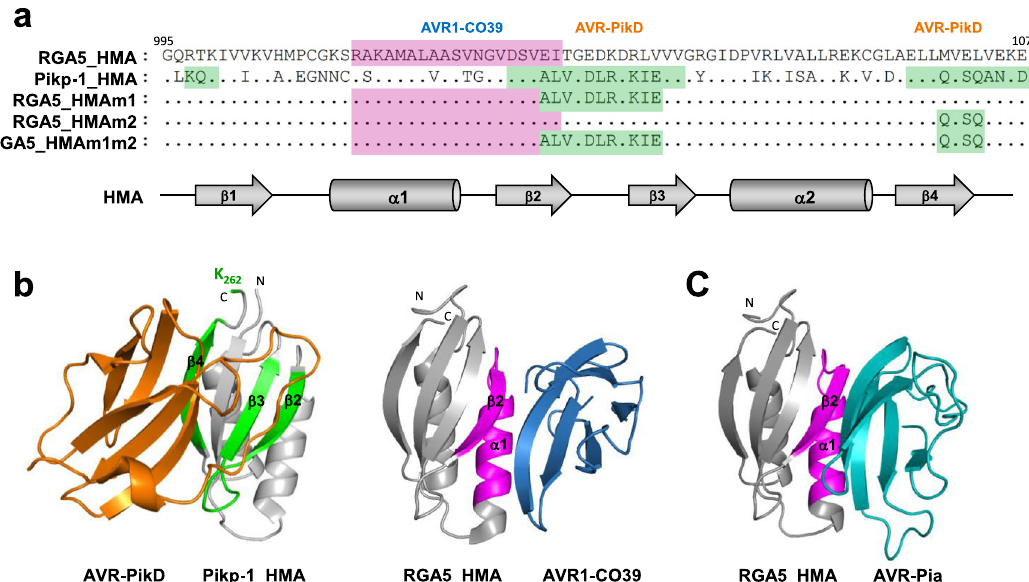
Fig. 1 Structure-guided engineering of the HMA domain of RGA5 to introduce the AVR-PikD binding surface. a Sequence alignment of the RGA5 and Pikp-1 HMA domains. The residues constituting the AVR1-CO39 and AVR-PikD binding interfaces are highlighted in pink and green, respectively. Residues in strands β 2/ β 3 and β 4 targeted respectively by the m1 and m2 mutations are highlighted in green in the different RGA5_HMA variants. Secondary structure elements of the HMA domain are shown below in gray. b Crystal structure of the AVR-PikD/Pikp-1_HMA (left) and AVR1-CO39/RGA5_HMA (right) complexes (PDB_6G10 and PDB_5ZNG, respectively). AVR-PikD (orange) binds the HMA domain of Pikp-1 through residues in β 2/ β 3, β 4, and K262 (green) and AVR1-CO39 (blue) interacts with the HMA domain of RGA5 through its α 1/ β 2 surface (pink). c 3D model of RGA5_HMA in complex with AVR-Pia (light blue) based on the AVR-Pia/Pikp-1_HMA template structure